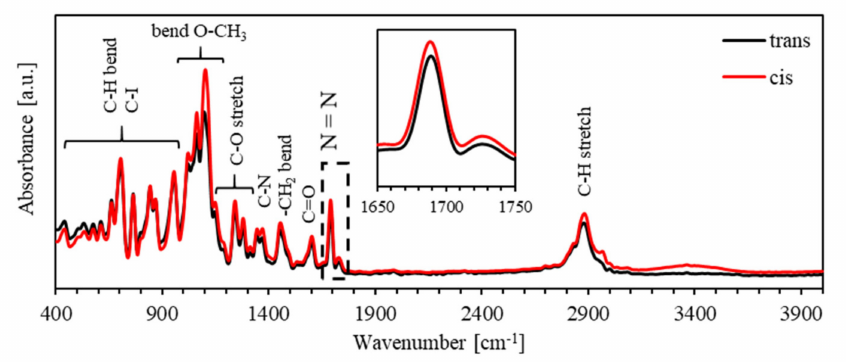
Figure 7. The FTIR spectra of trans - and cis -phases of (PEO-BDK-MR)/I 2 (0.1%) complex composite thin